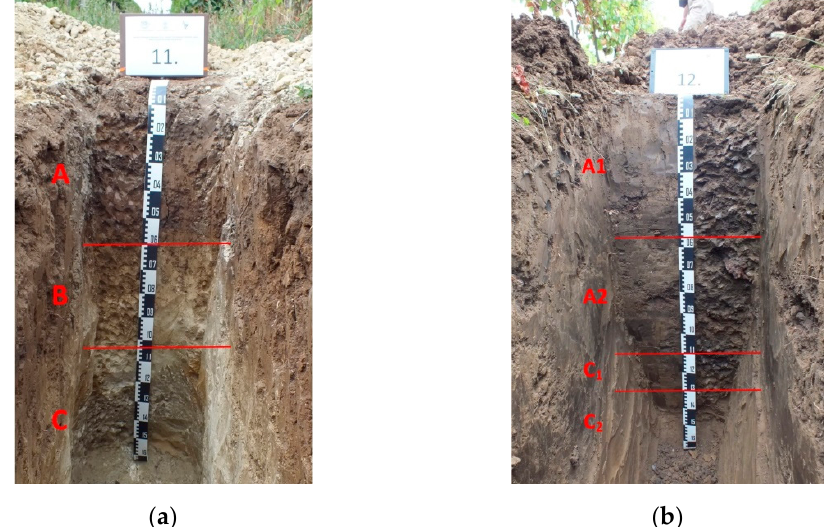
Figure 4. Soil profiles: ( a ) Locality Lipovac—Eutric Cambisol (Clayic), (CM-eu-ce). ( b ) Locality Gornje Zleginje—Haplic Vertisol, (VR-ha).